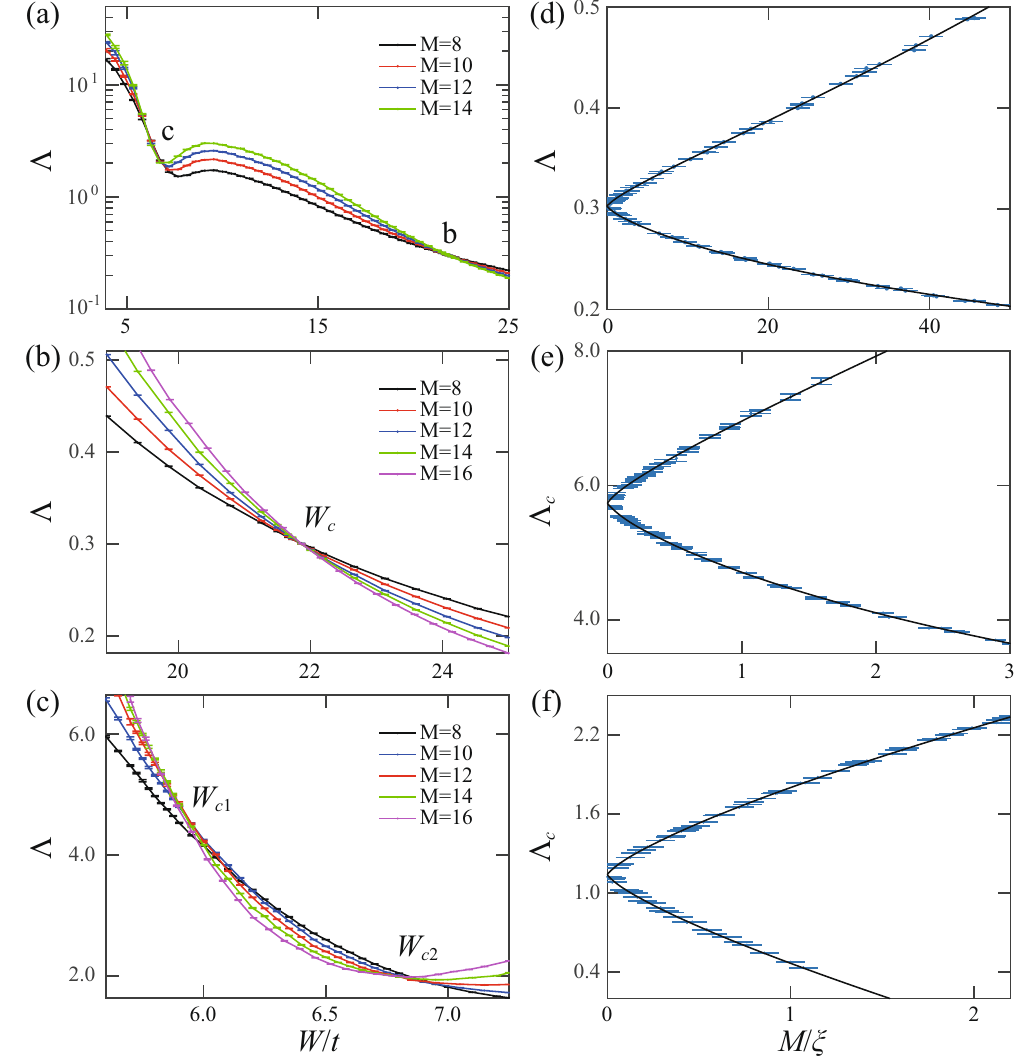
Figure 1. ( a ) The normalized localization length as a function of W t / for various system sizes and with the parameters specified in the text. b and c indicate the possible quantum phase transition points. ( b , c ) The close-up shots of the possible transition regions around ( b and c ) in ( a ). ( d ) The scaling function obtained by collapsing data points around the critical point W in ( b ) into the smooth curves. ( e , f ) The scaling functions c obtained from the corrections to the single-parameter scaling ansatz by collapsing data points around the critical points W and W in ( c ) into the smooth curves, c 1 c 2